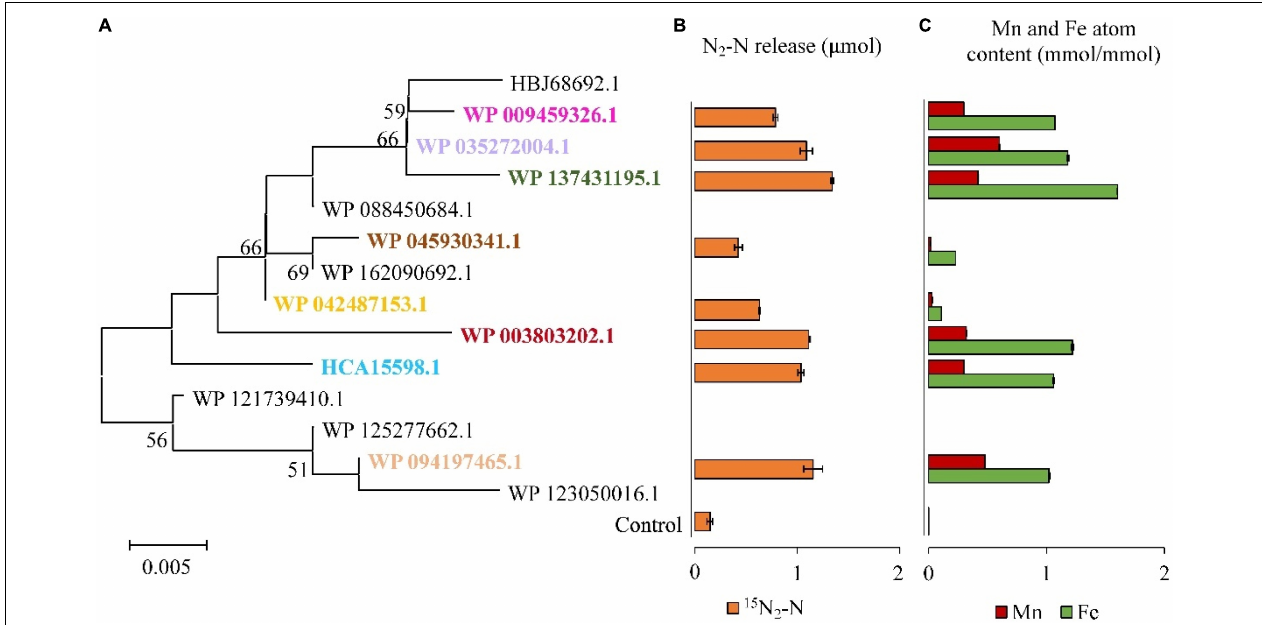
FIGURE 5 | Hydroxylamine oxidation activities of DnfAs from Alcaligenes strains. Phylogenetic tree of the representatives of all DnfA homologs defined in the genomes of all Alcaligenes strains deposited in GenBank (A) ; 15 N 2 release of the representatives of DnfA homologs from 15 NH 2 OH under 20% O 2 and 80% He in vitro (B) . The content of Fe and Mn atoms of DnfAs (C) . The data are shown as the mole content of metal atoms per mole of DnfA.